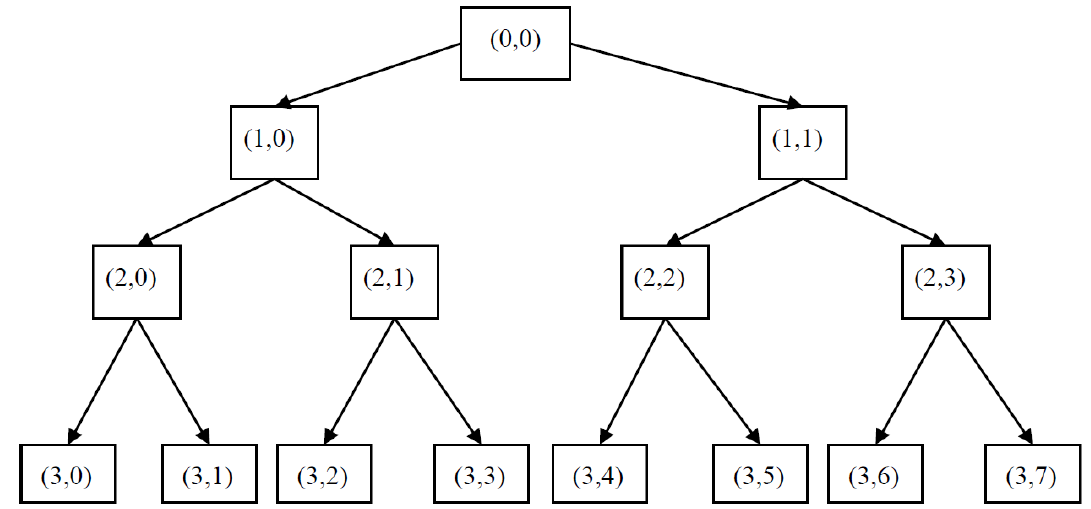
Figure 2. The typical binary wavelet packet transform (WPT) decomposition structure (three layers).